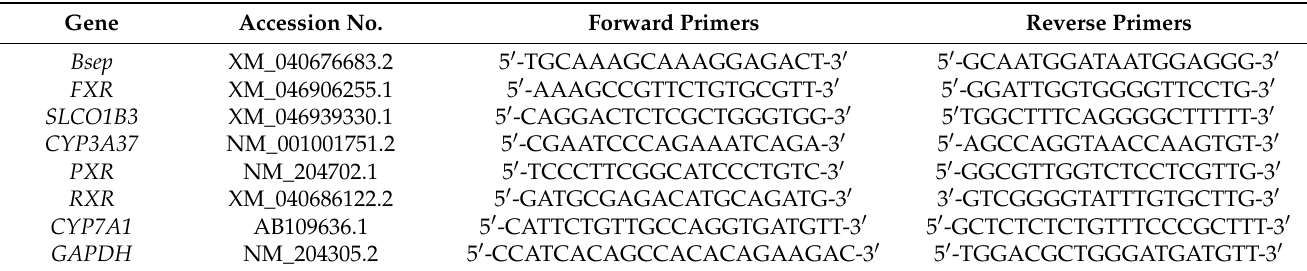
Table 2. PCR primer